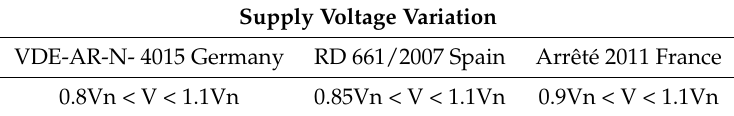
Table A3. Voltage